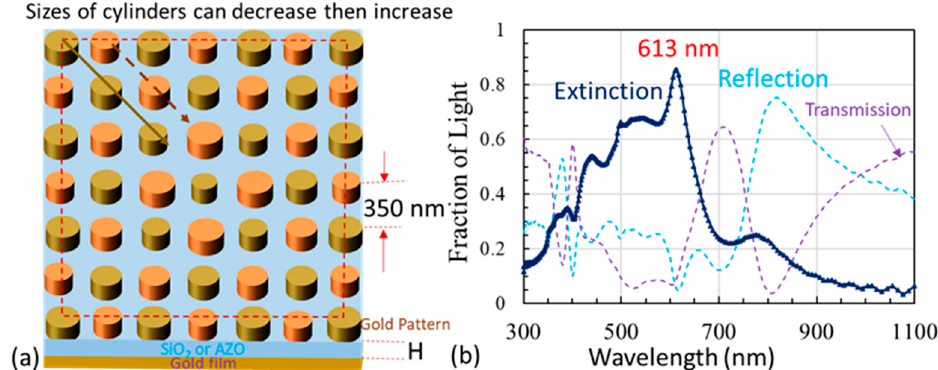
Figure 1. ( a ) Schematic of a 6 Λ S × 6 Λ S unit cell of graded photonic super-crystal (GPSC) with gold cylinders. ( b ) Simulated reflection, transmission and extinction for Au GPSC on a glass slide.